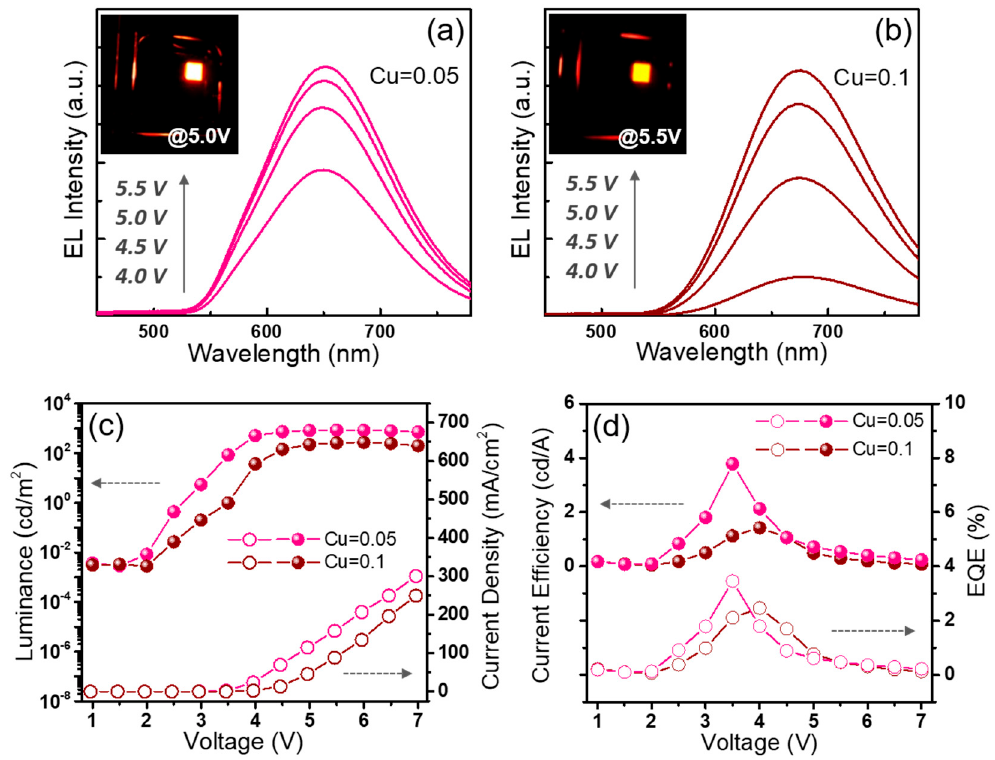
Figure 5. Voltage-dependent electroluminescence (EL) spectral evolutions along with representative EL images (insets) of QLEDs with Cu-doped QDs with ( a ) 0.05 and ( b ) 0.1 mole fraction. Voltage-dependent variations of ( c ) luminance and current density and ( d ) current efficiency and EQE of the same devices as in ( a , b ).